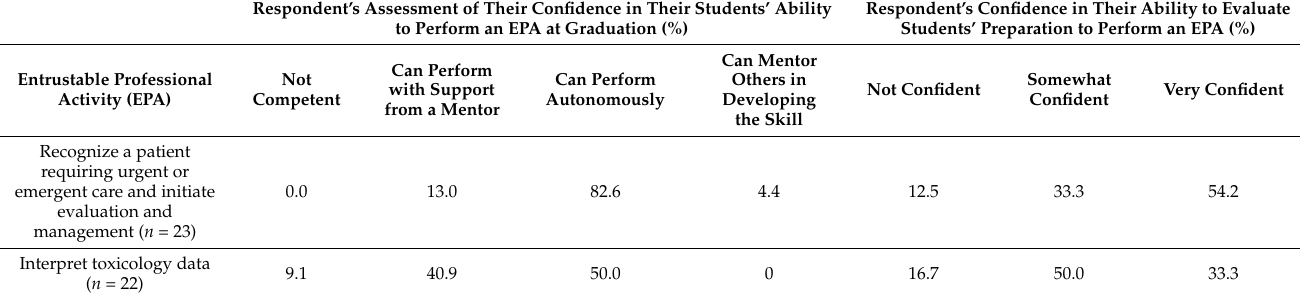
Table 3. Respondent perceptions regarding entrustable professional activities associated with toxicol- ogy (number of responses varies per